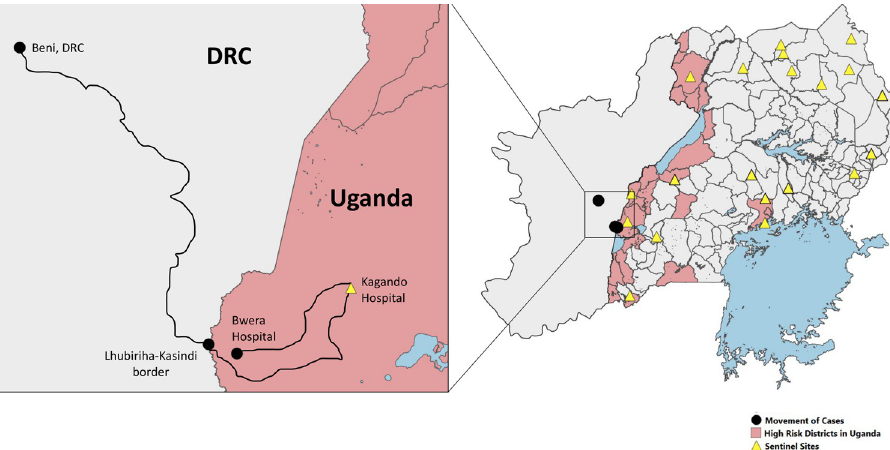
Fig 1. A map of Uganda showing the movement of cases, high-risk districts, and location of VHF sentinel surveillance sites. The black dots connected by lines show the movement of cases, districts designated as high-risk for EBOV spillover are colored pink, and VHF sentinel surveillance sites are indicated by yellow triangles (Shape file Source: www.diva-gis.org/gdata and